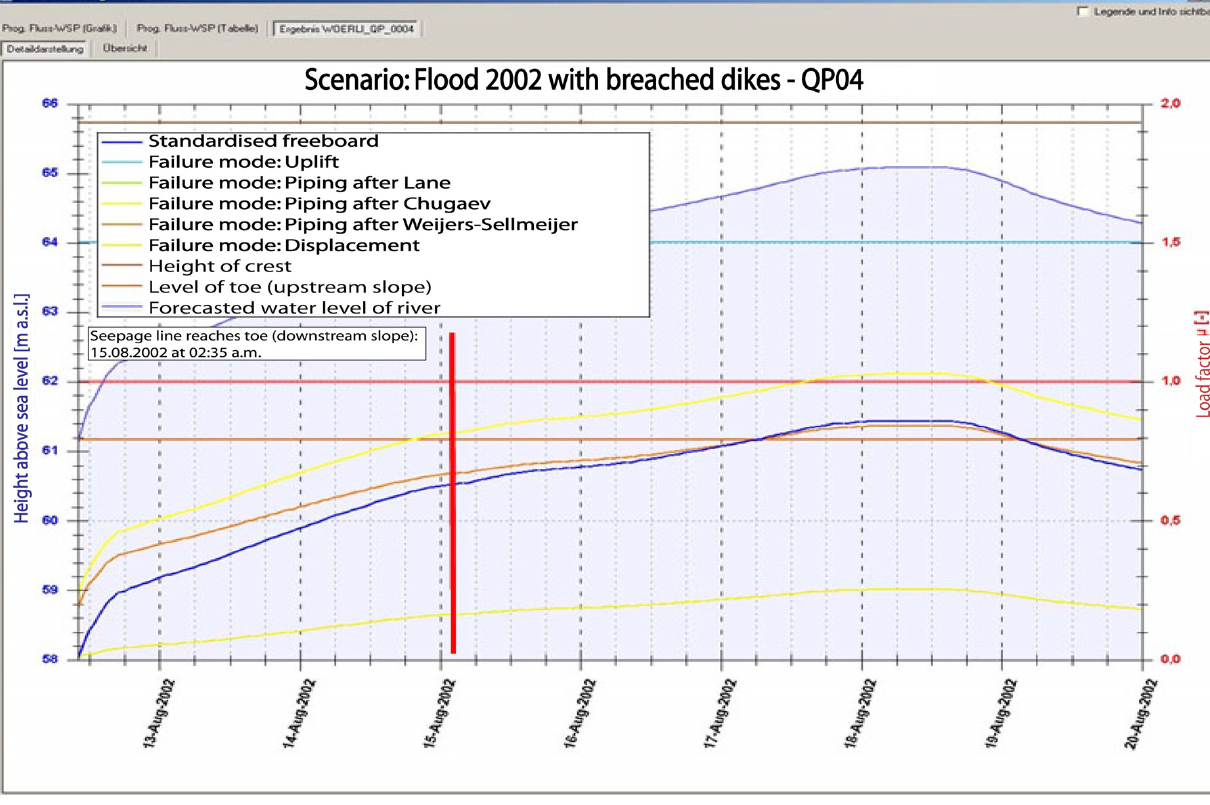
Fig. 8. Evaluation module – illustration of the result of an evaluation of a dike cross section for different failure modes (basis: szenario